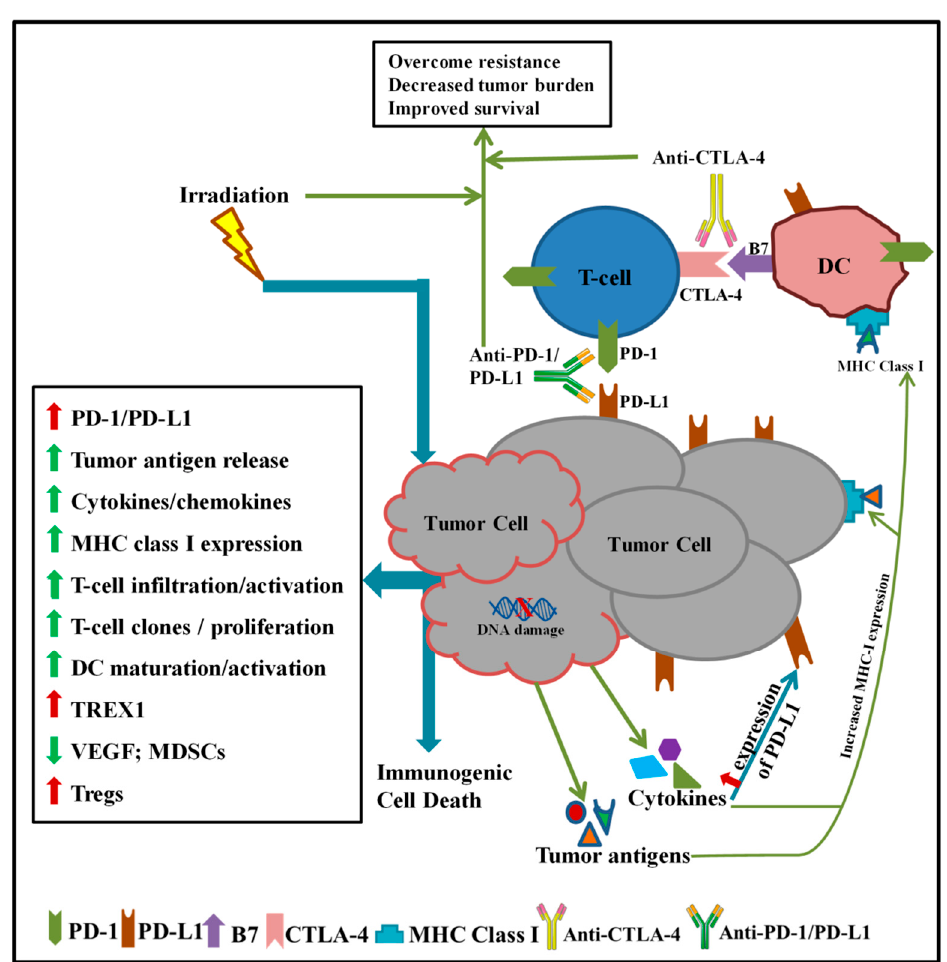
Figure 1. Schematic representation of radiation therapy (RT) and/or checkpoint inhibition (CPI) effects in the tumor microenvironment (TME).